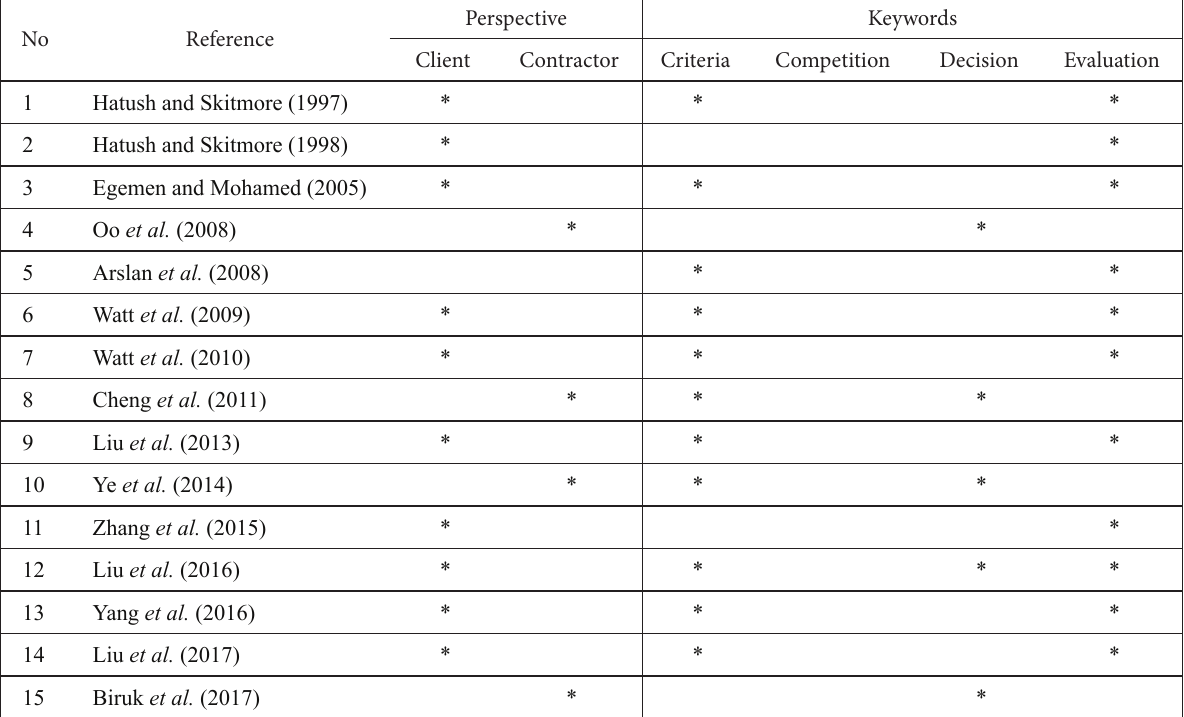
Table 1. A list of relevant studies on competitive